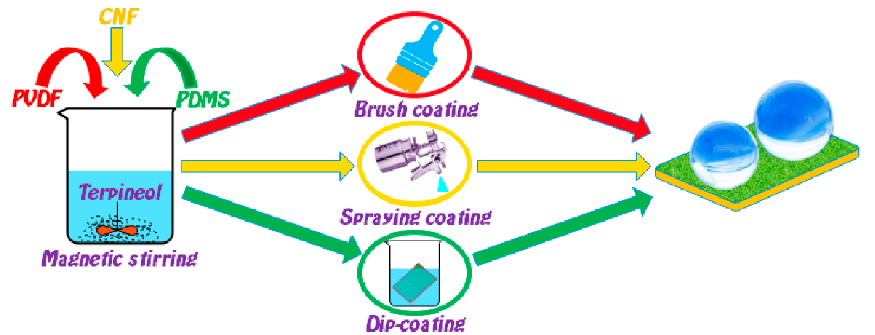
Figure 1. Schematic diagram of the preparation process of the flexible conductive superhydropho- bic coating. bic